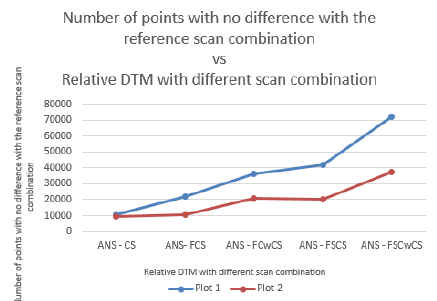
Figure 8. The graph represents the number of points with no difference with the reference scan combination Vs Relative DTM with different scan